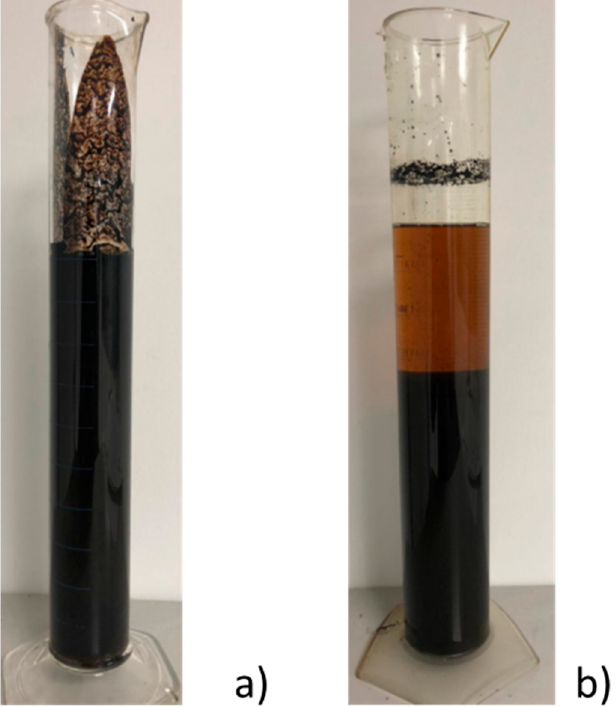
Figure 4. Pictorial representation of Alma bitumen emulsions obtained with liquid pitches (LP) additive ( a ), and without LP additive ( b ).